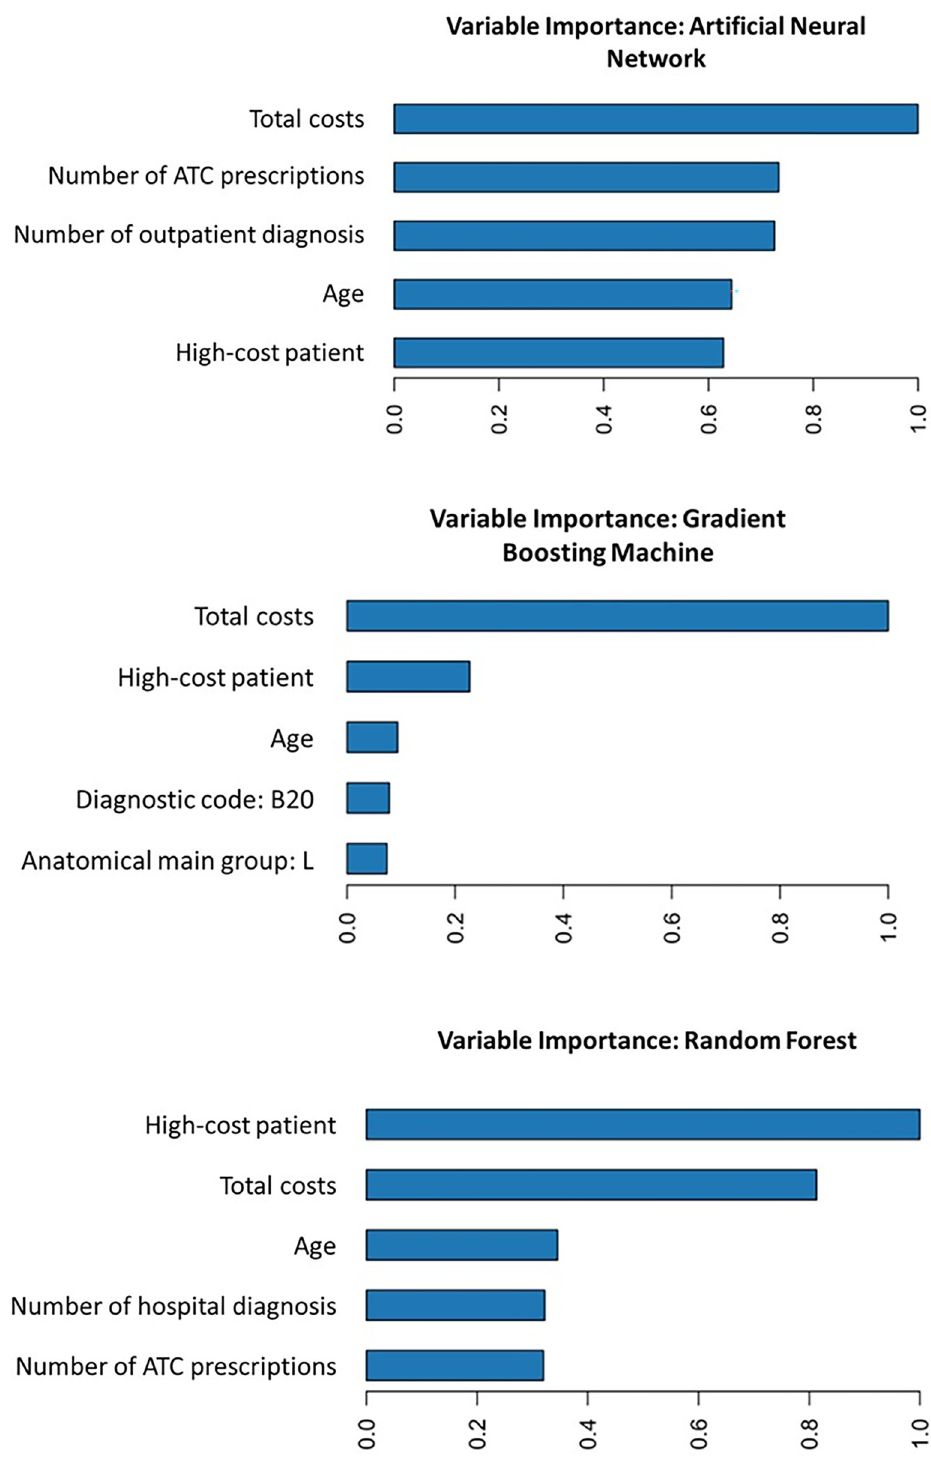
Fig 3. Variable importance for each selected model/algorithm. a) Artificial neural network, b) Gradient boosting machine, c) Random forest.